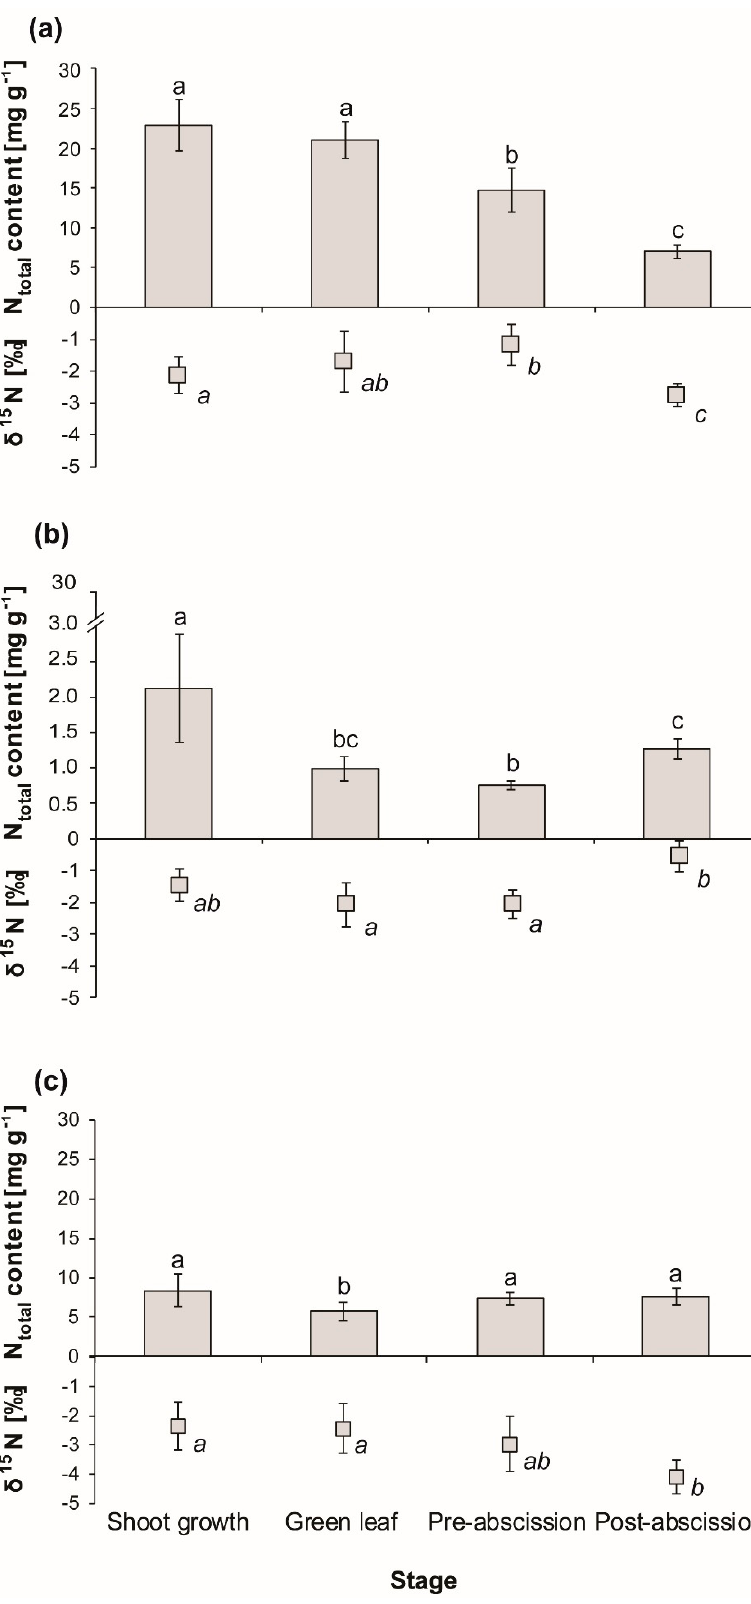
Figure 2: Seasonal pattern of N content and δ 15 N in coarse roots (a) , sapwood (b) , and leaves (c) of Fagus crenata Blume. Leaves post-abscission stage values represent fresh litter. The error bars denote SD ( n = 9), p < 0.05.